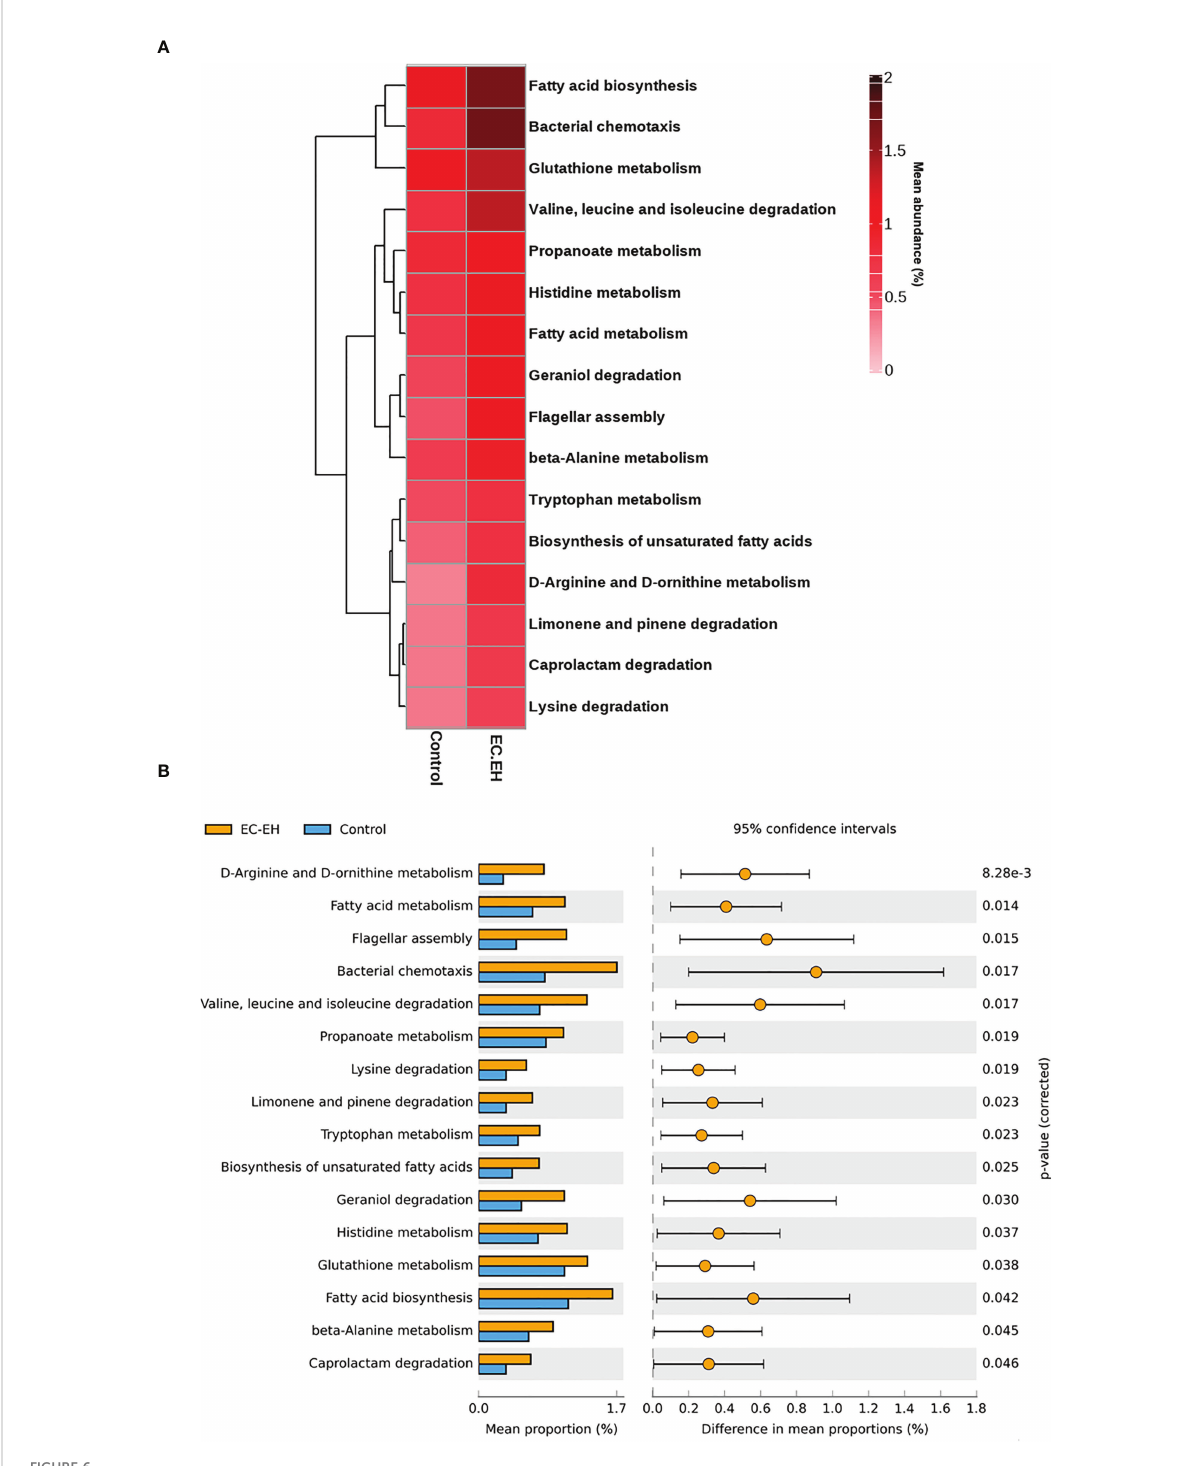
FIGURE 6 PICRUSt prediction of functional pathways in endometrial lavage microbiota of patients with EC/EH versus control women. (A) Relative abundance of different functional pro fi les. (B) Functional pathways upregulated in patients with with